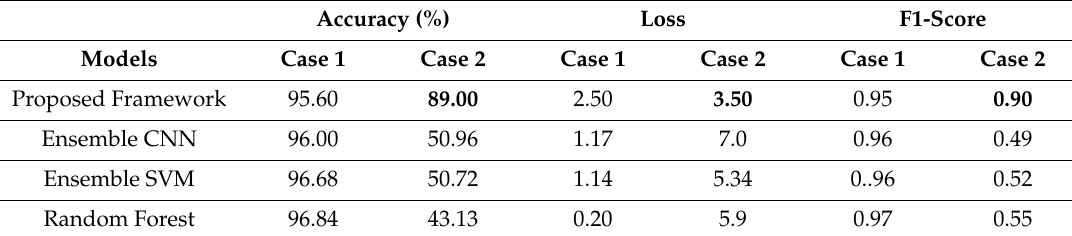
Table 6. Comparative analysis of the proposed framework and state-of-the-art models. Accuracy (%) Loss